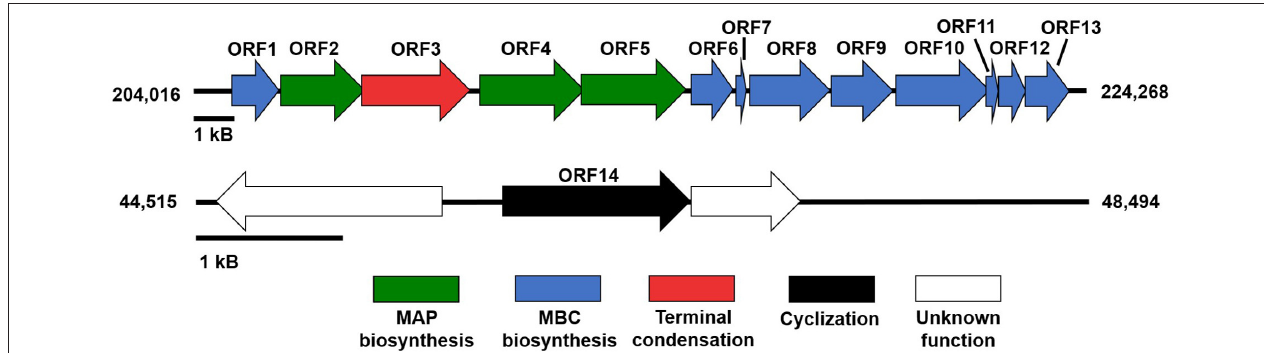
FIGURE 5 | Prodiginine biosynthetic gene cluster composed of MAP pathway (green), MBC pathway (blue), and terminal condensation (red). Gene involved with cyclization (black) was located outside of prodiginine biosynthetic gene cluster, but was directly involved in prodiginine